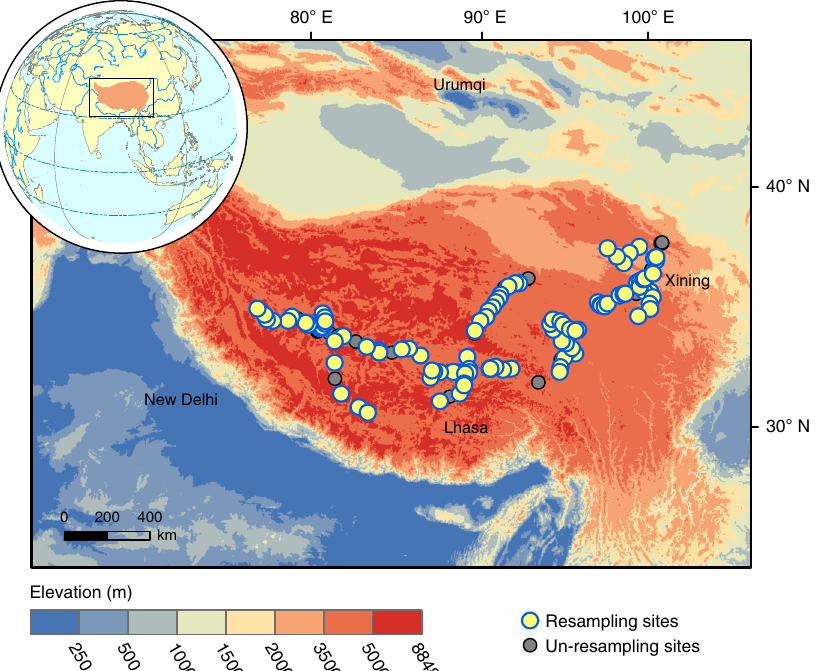
Fig. 1 Distribution of sampling sites on the Tibetan Plateau. Yellow and grey circles jointly represent the original 135 sampling sites surveyed during the period of 2001 ~ 2004. Among them, the yellow circles denote the 107 resampling sites investigated during 2013~2014 and the grey circles indicate the unresampling sites due to practical limits such as road rebuilding. The background map represents the elevation across the study